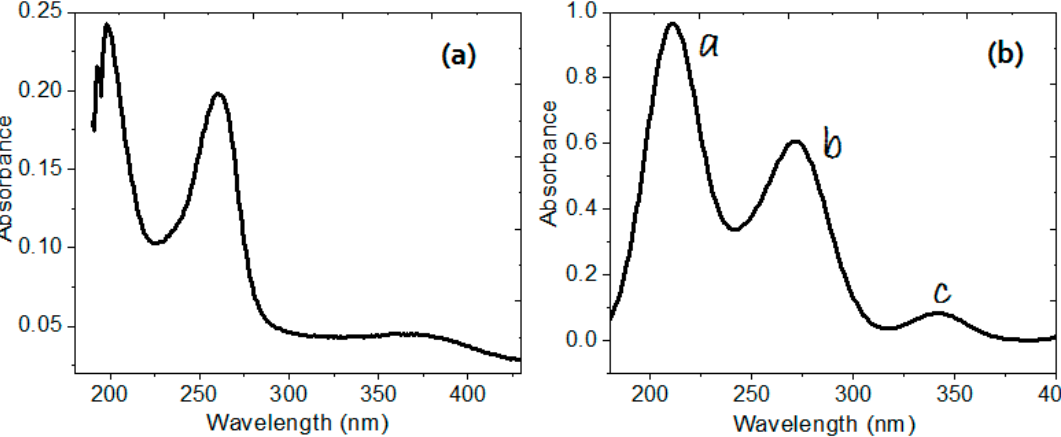
Figure 6. Absorption spectrum of ZnQ 2 -TCNQ obtained by ( a ) UV–VIS spectroscopy and ( b ) simulated absorption spectrum. A Gaussian broadening of 30 nm was applied.